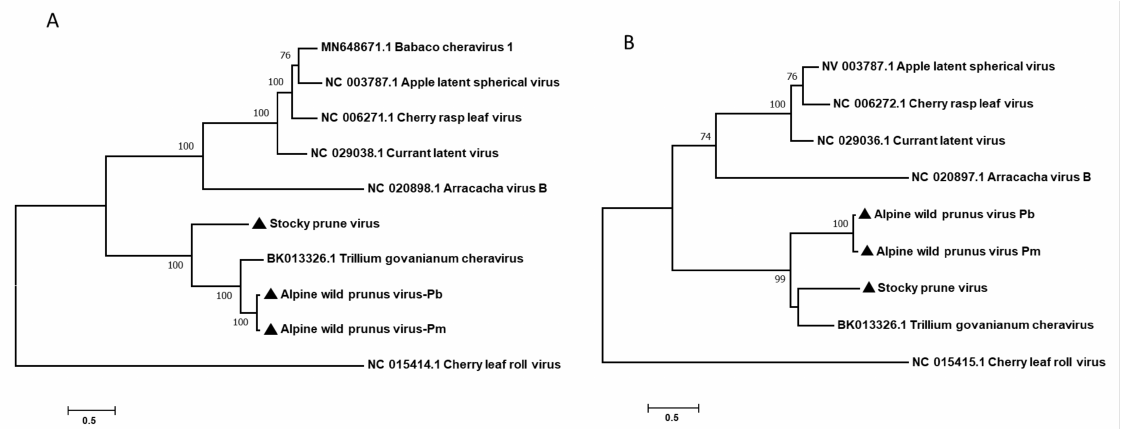
Figure 2. Phylogenetic trees reconstructed using the alignment of amino acid sequences of RNA1- encoded polyprotein P1 ( A ), and RNA2-encoded polyprotein P2 ( B ) of representative members of the genus Cheravirus . Trees were generated using the Maximum Likelihood method. The statistical significance of branches was evaluated by bootstrap analysis (1000 replicates). Cherry leaf roll virus (CLRV) was used as an outgroup. Bootstrap values less than 70% were removed. Viruses characterized in the present study are marked by black triangles. AWPV-Pb: alpine wild prunus virus- P. brigantina ; AWPV-Pm: alpine wild prunus virus prunus- P. mahaleb ; StPV: stocky prune virus; AVB: arracacha virus B; ALSV: apple latent spherical virus; BabChV-1: babaco cheravirus-1; CRLV: cherry rasp leaf virus; CuLV: currant latent virus; TgCV: trillium govanianum cheravirus. Accession numbers are given before virus abbreviations. The bars represent the genetic